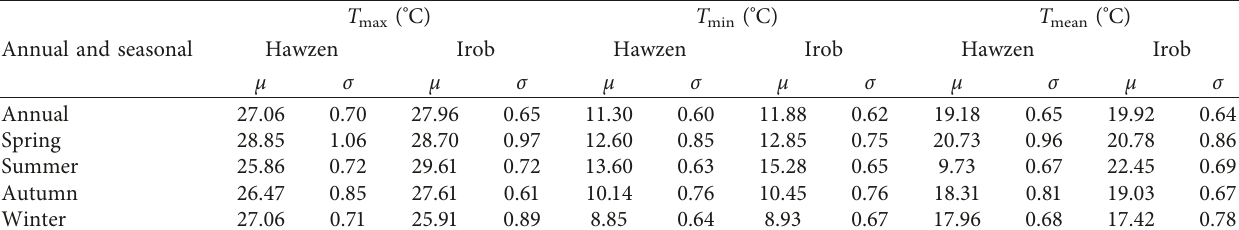
Table 5: Mean maximum, minimum, and annual temperatures ( ° C) in Hawzen and Irob in 1983–2015. Annual and seasonal